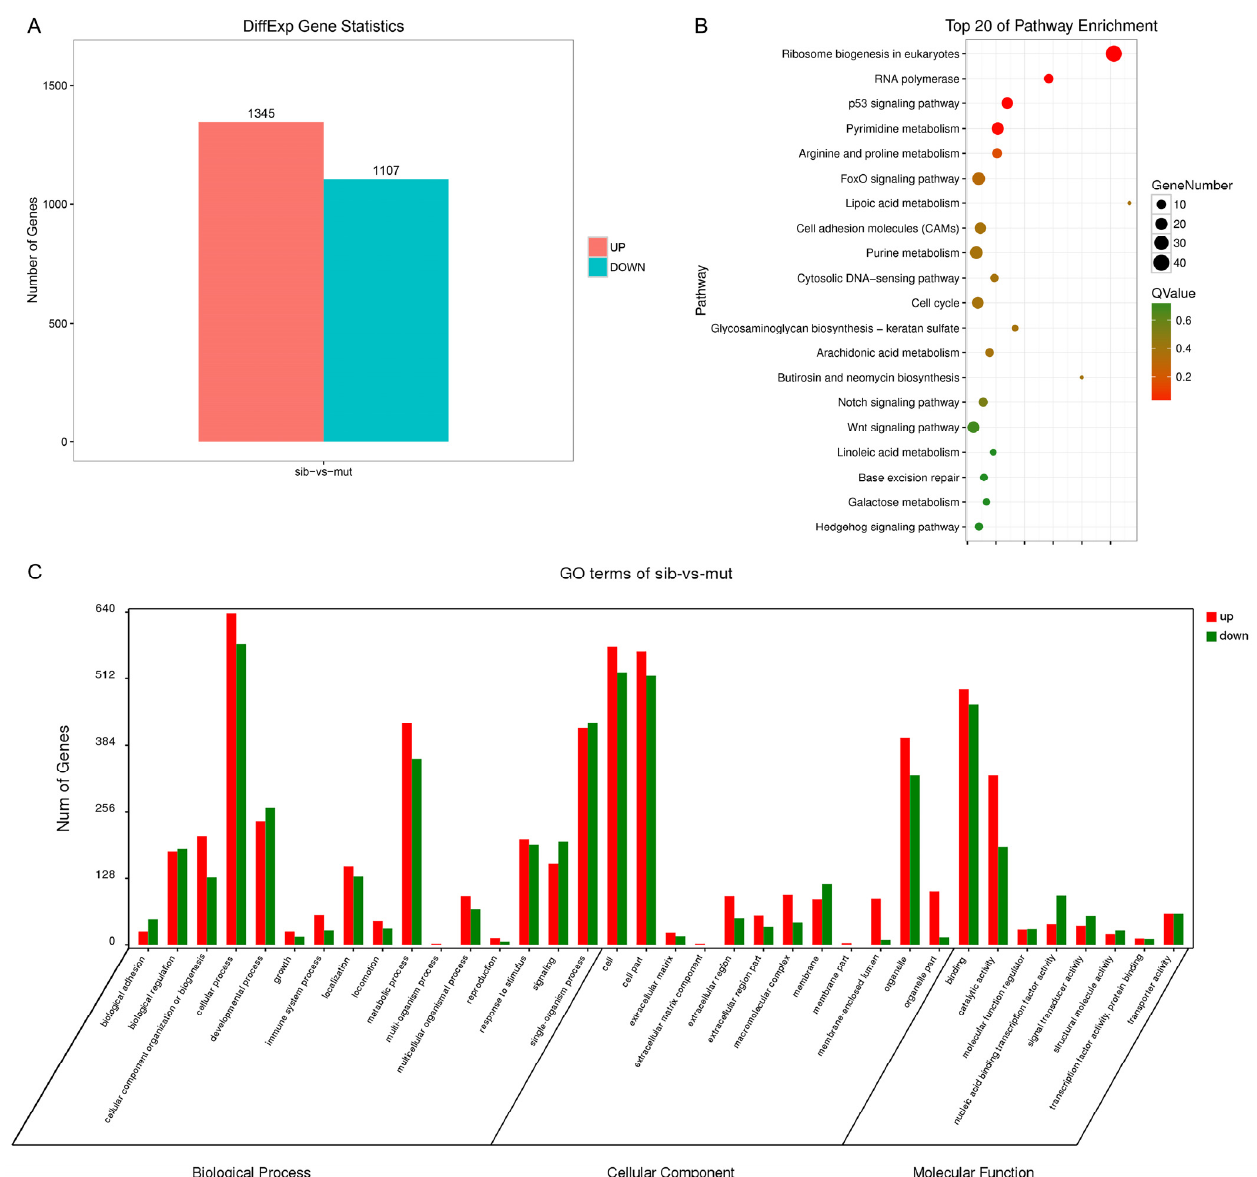
Figure 4. Transcriptome analysis of nop56 mutants. ( A ) Differential expression analysis of genes between siblings and mutant groups. ( B ) Pathway enrichment analysis identified the top 20 pathways affected in mutants. ( C ) Gene Ontology analysis between siblings and mutants.